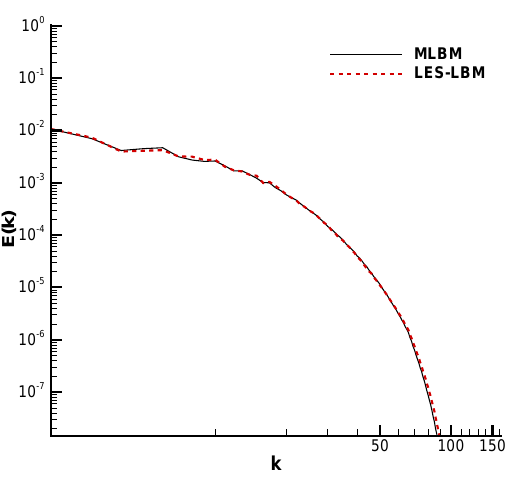
Fig. 6 Comparison of energy spectrum between MLBM and LES-LBM for Re λ = 225 at t = 5.